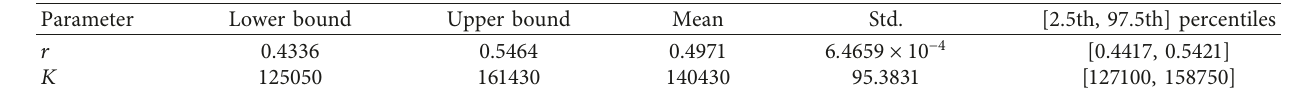
Figure 7: Parameter histograms of Gompertz model of the IABC-SMC algorithm. (a) Estimation of r . (b) Estimation of K . Here, the initial � 22 , a � 0 . 4 , T � 6 , and t � 12. states are n � 6000 ,x 0 Table 8: Parameter ranges and the statistics of the Gompertz